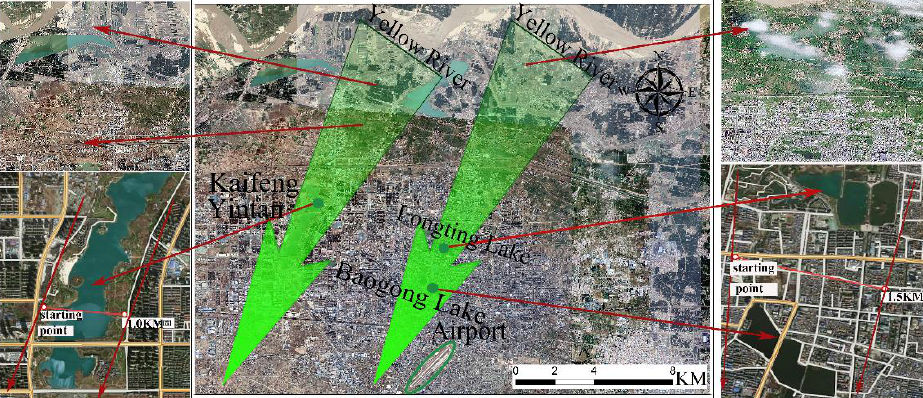
Figure 12. Planning of ventilation corridors in Kaifeng.